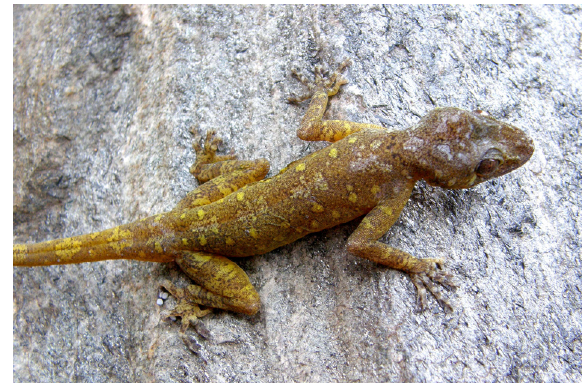
Image 3. Calodactylodes aureus - dorsal view